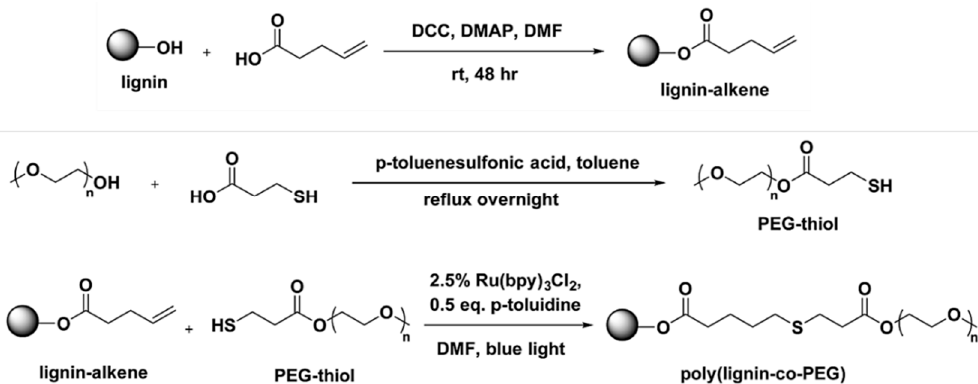
Figure 34. Lignin modification to prepare lignin-alkene and thiol-ene reaction of lignin-alkene and PEG-thiol. Reproduced with permission [112].